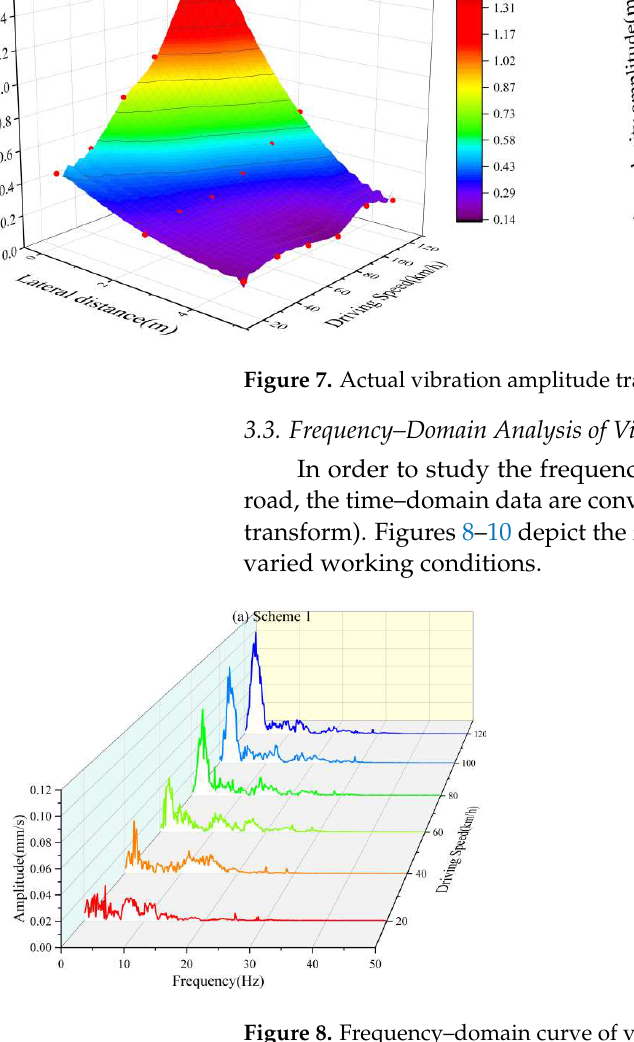
Figure 6. Actual vibration amplitude longitudinal decay curve.